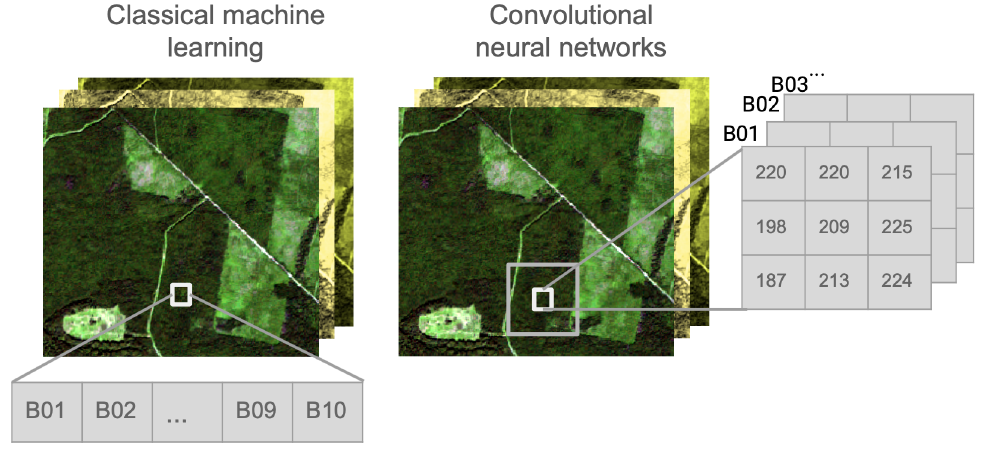
Figure 2. Difference between classical machine learning and deep learning